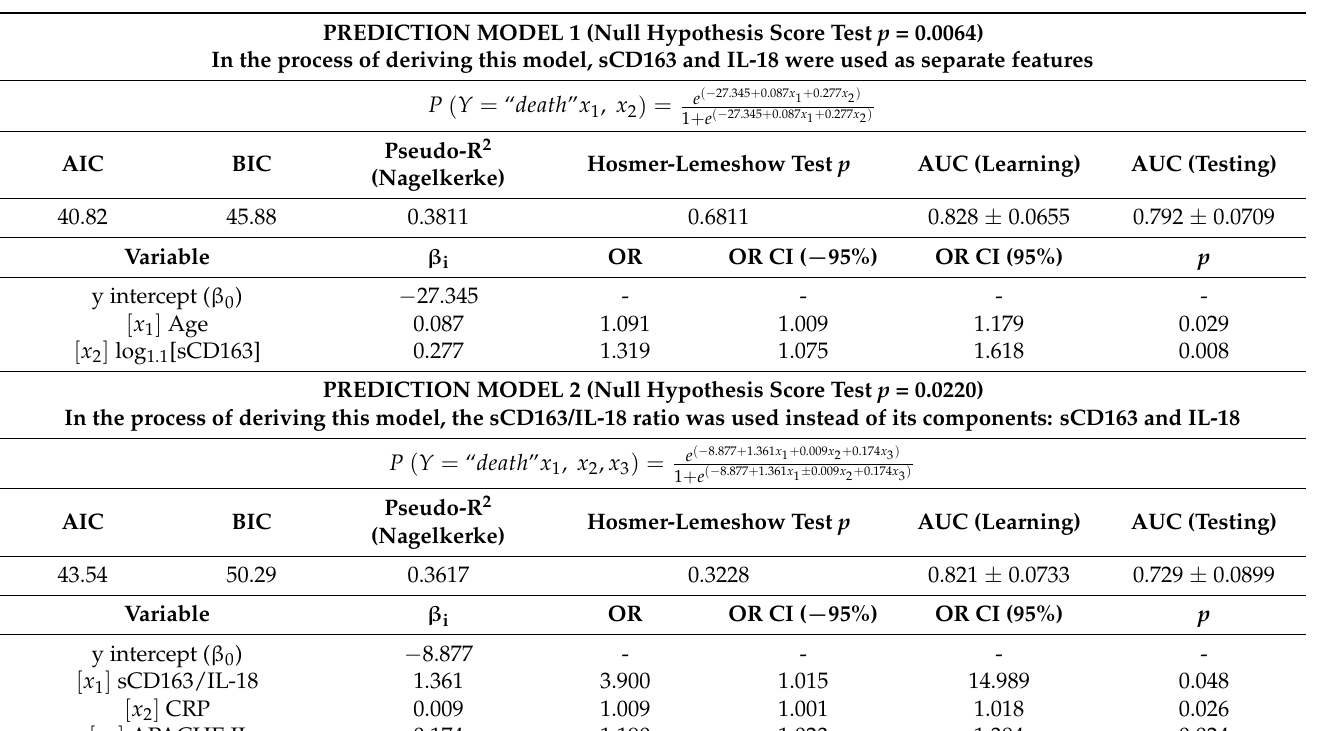
Table 4. Logistic regression models of the best fit describing the association between the selected predictors and in-hospital death in septic patients.